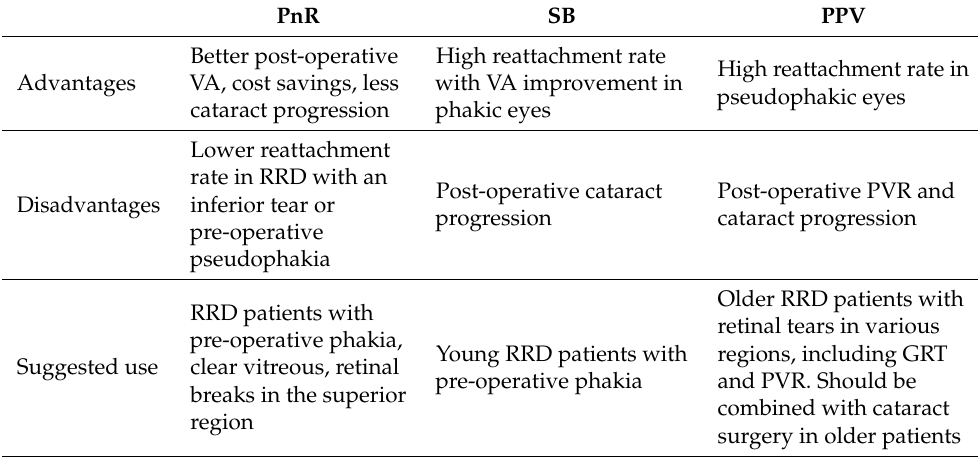
Table 1. Advantages and disadvantages of scleral buckling (SB), pars plana vitrectomy (PPV), and pneumatic retinopexy